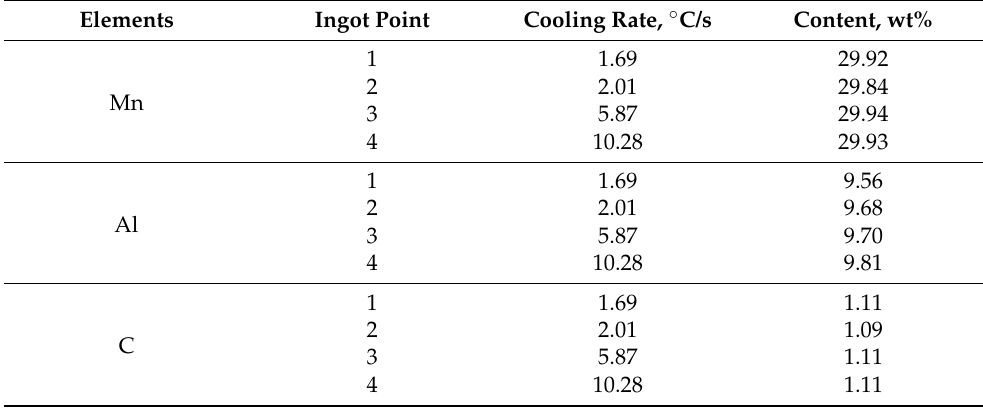
Table 3. Element content at the center of the ingot with different